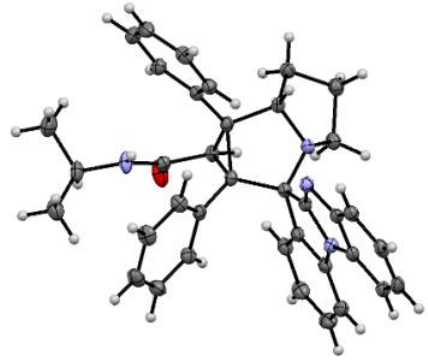
Figure 2. ORTEP representation of the molecular structure of 4f (CCDC 2195042).